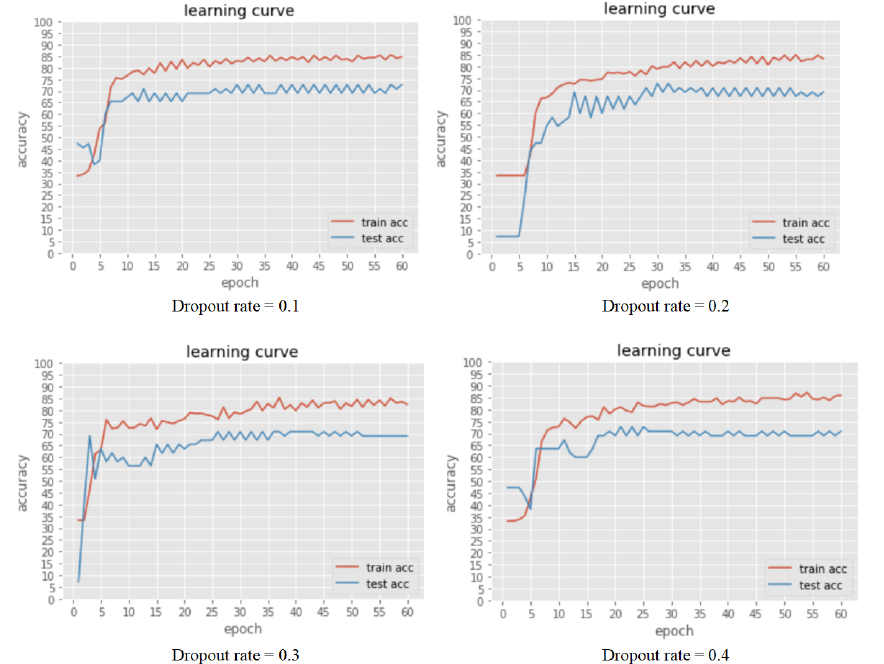
Figure 4. The accuracy of train and test dataset under different dropout rate (hidden layers = 5, Neurons in each layer = (25, 200, 400, 300, 100, 50,